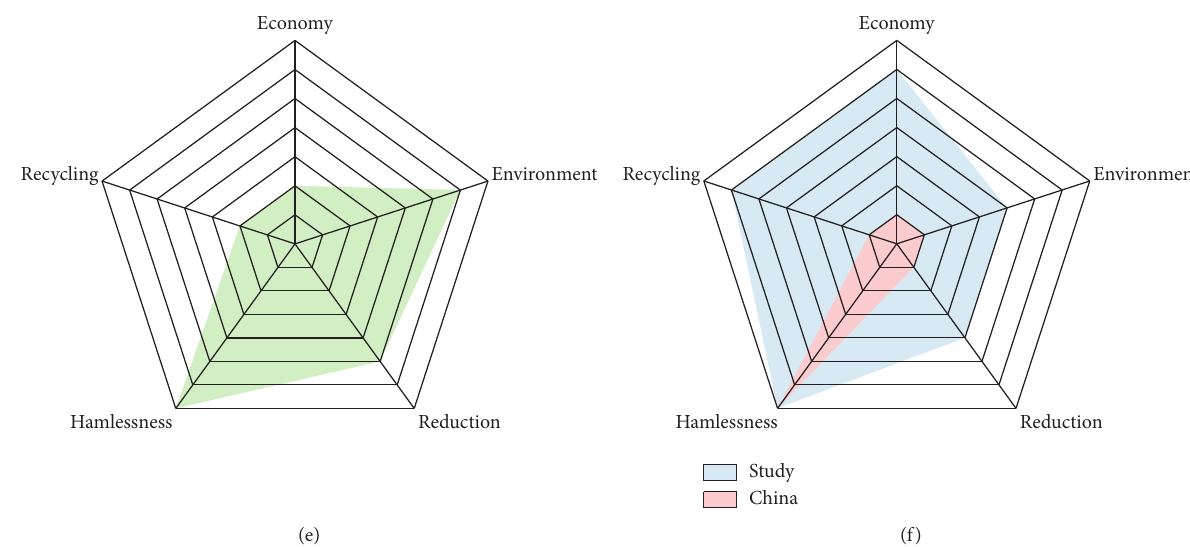
Figure 5: Comprehensive ability comparison in (a) Germany, (b) the US, (c) the UK, (d) Sweden, (e) Japan, and (f) China and the